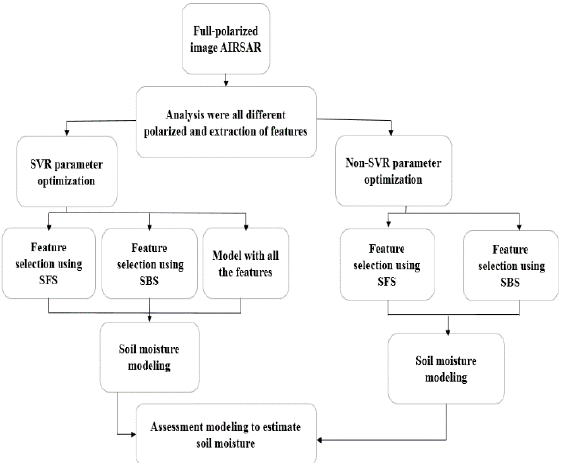
Figure 1. The General trend in soil moisture modeling